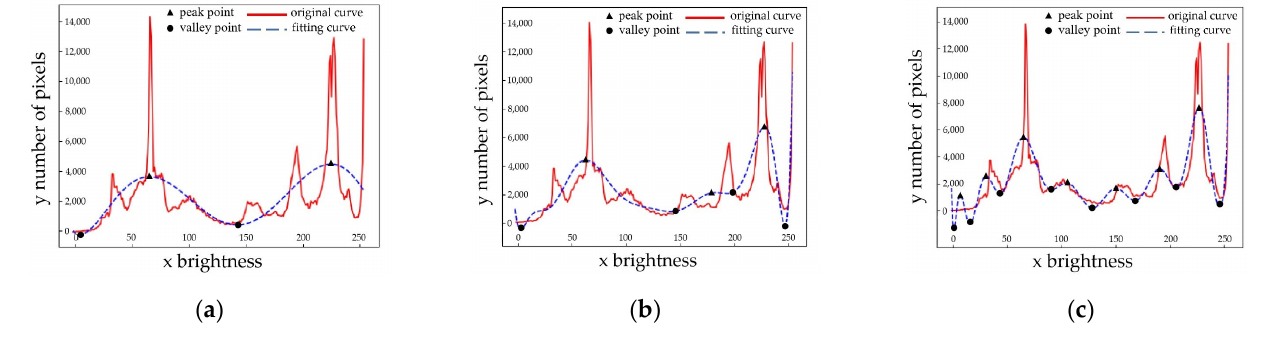
Figure 10. Under-fitting, fitting, and over-fitting curves; ( a ) under-fitting curve; ( b ) fitting curve; ( c ) over-fitting curve.